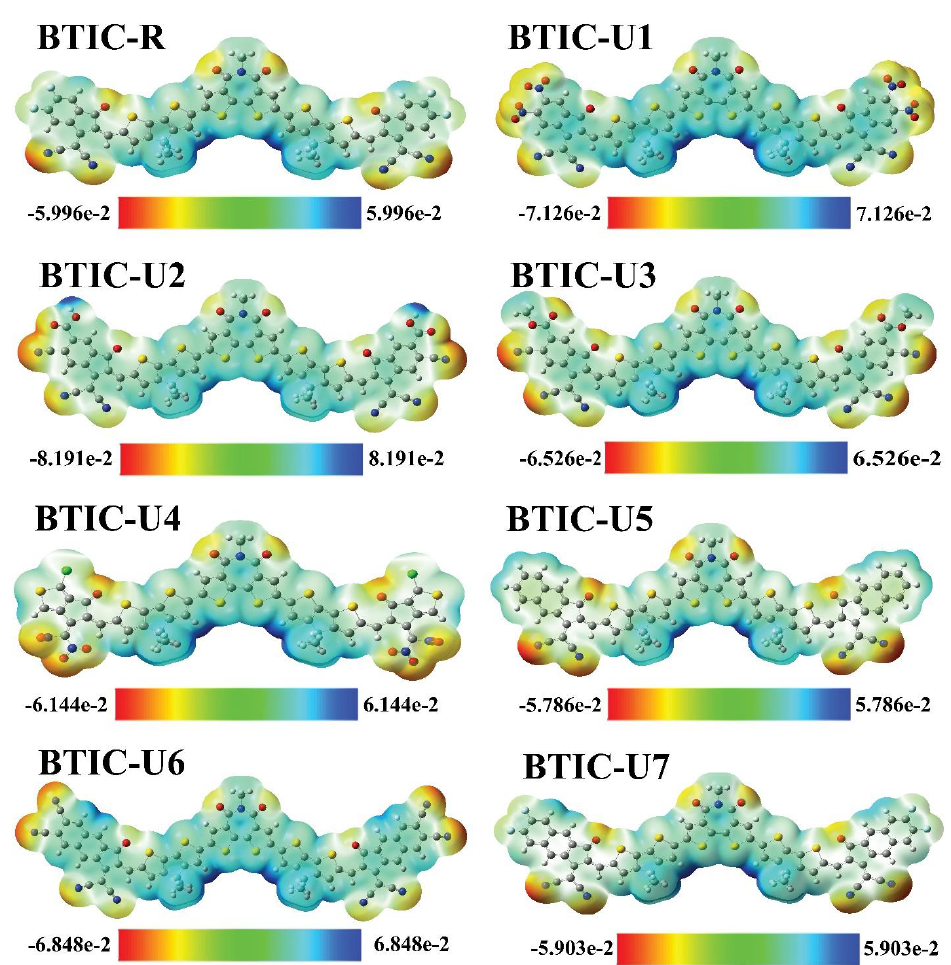
Figure 8. ESP maps of BTIC − R and BTIC − U1 to BTIC − U7.